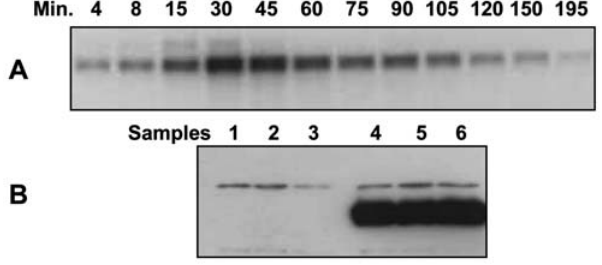
Figure 1. Treatment of S.solfataricus with 30 m M H 2 O 2 leads to an up-regulation in transcription and translation of DPSL. A ) Time course northern blot analysis for dpsl mRNA after treatment with 30 m M H 2 O 2. B ) Western blots for DPSL, 105 minutes after addition of 30 m M H 2 O 2 . Lanes 1–3 controls, 4–6 are from the three biological replicates used for the microarray and proteomics experiments. The polyclonal antibody to DPSL protein recognizes a background protein of slightly greater molecular weight than DPSL.